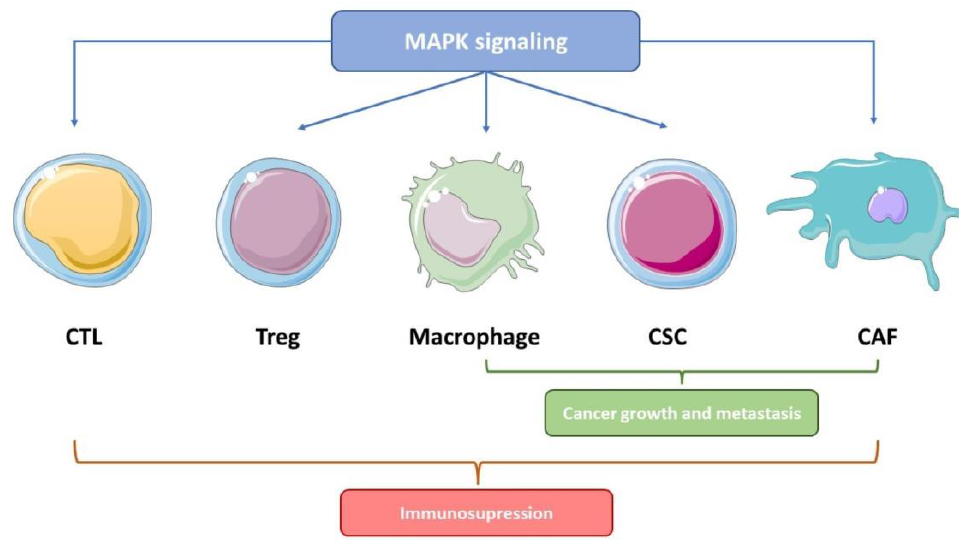
Figure 3. Interactions between MAPK signaling with cells in the tumor microenvironment (TME). The p38 MAPK pathway plays a key role in positive interactions between MAPK signaling with tumor-promoting cells within the TME, including cancer-associated fibroblasts (CAFs), cancer stem cells (CSCs), tumor-associated macrophages (TAMs), and regulatory T cells (Tregs), which, together with the exchange of signals with antitumor cytotoxic T lymphocytes (CTLs), provide an immunosup- pressive system for cancer progression. MAPK interactions with CAF, CSCs, and TAMs also promote tumor growth and metastasis. Figure created using Servier Medical Art by Servier, which is licensed under a Creative Commons Attribution 3.0 Unported License: https://smart.servier.com (accessed on 23 November